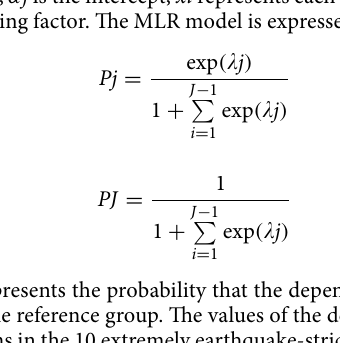
Actual category